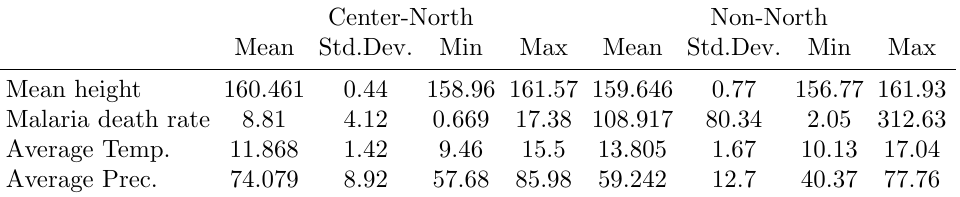
Table 2: Summary of statistics (Center-North vs South)